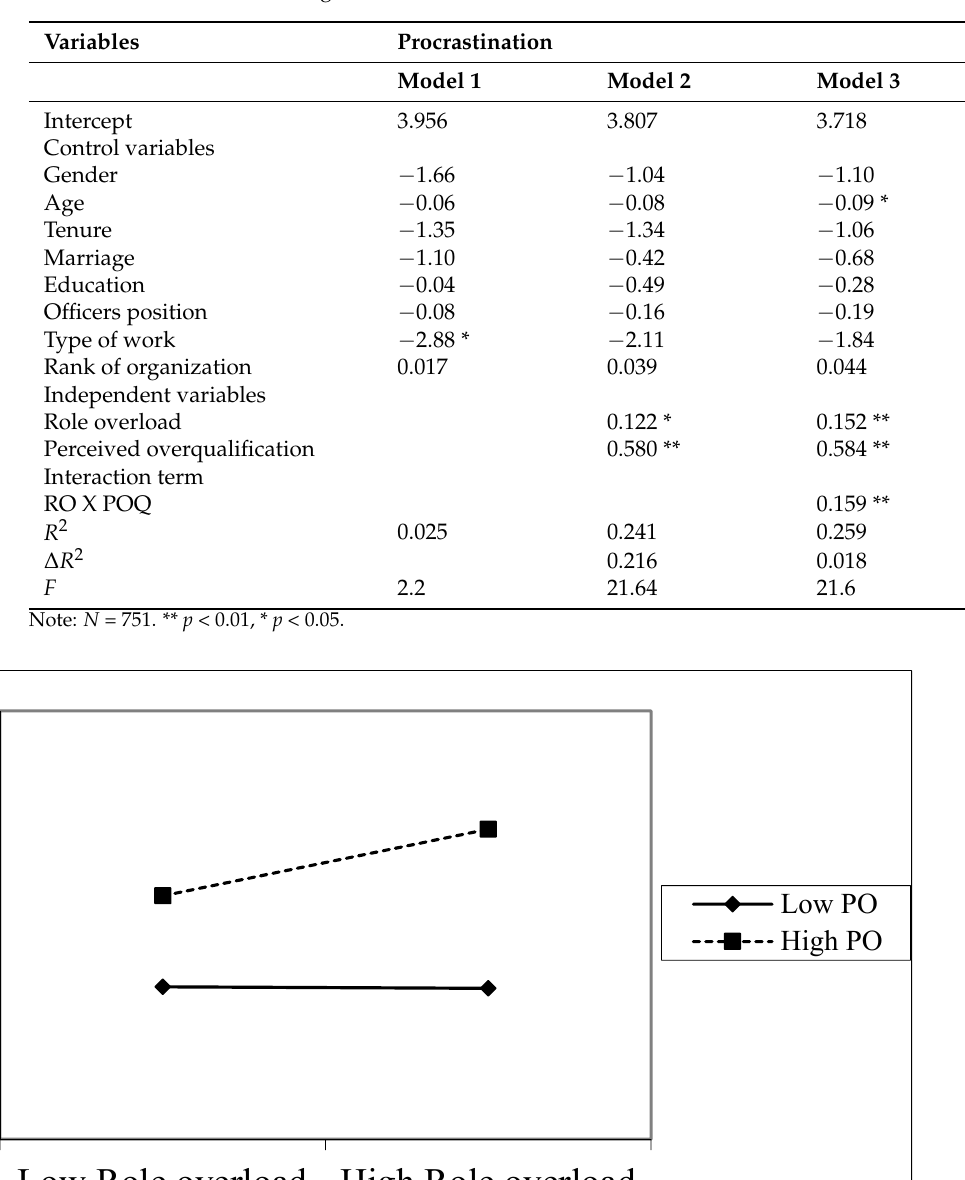
Table 4. Results of moderating effects.